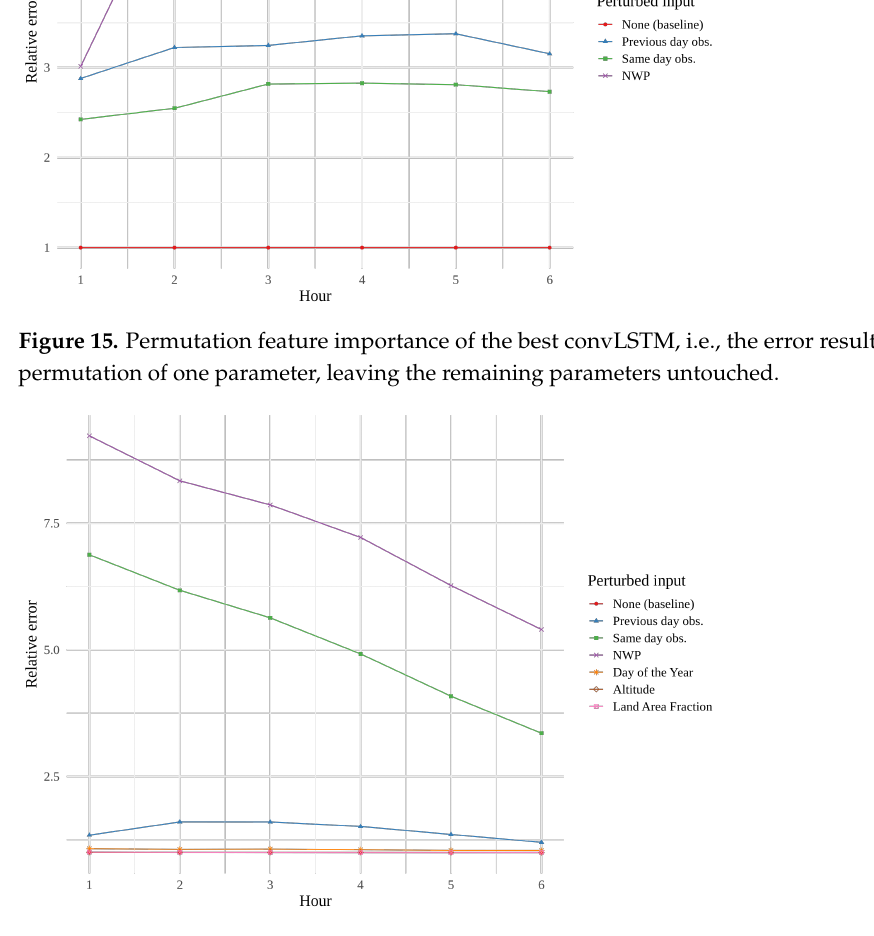
Figure 16. Permutation feature importance of the best tower network, i.e., the error resulting from the permutation of one parameter, leaving the remaining parameters